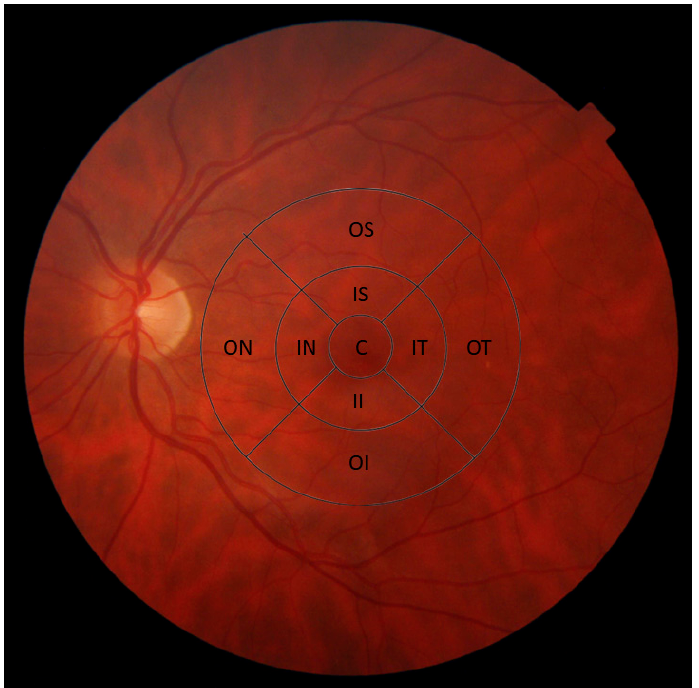
Figure 2. Early treatment diabetic retinopathy study (ETDRS) macular grid depicting nine macular sectors. Abbreviations: C—central; IS—inner superior; IT—inner temporal; II—inner inferior; IN—inner nasal; OS—outer superior; OT—outer temporal; OI—outer inferior; ON—outer nasal.